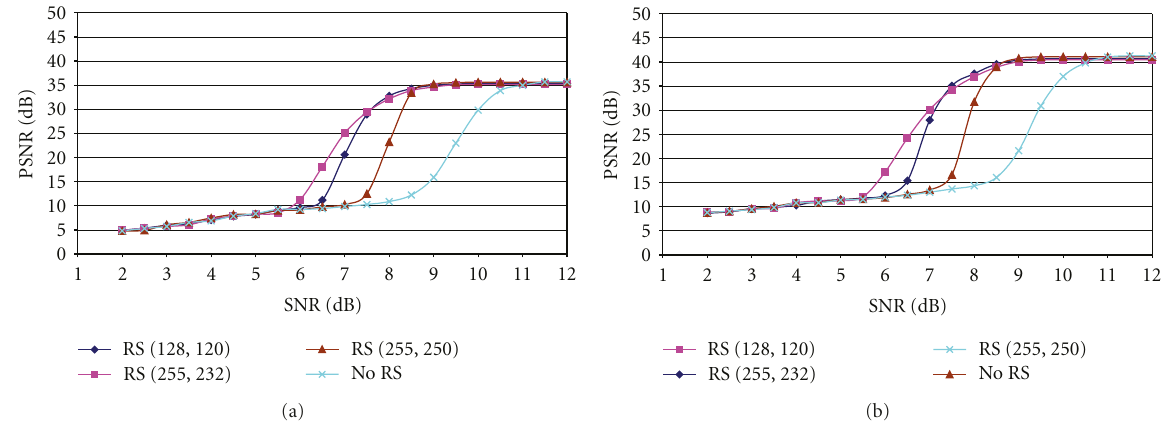
Figure 13: PSNR evolution for “Foreman” and “Akyio” sequences in CIF resolutions over BSC channel for di ff erent protection levels with RS